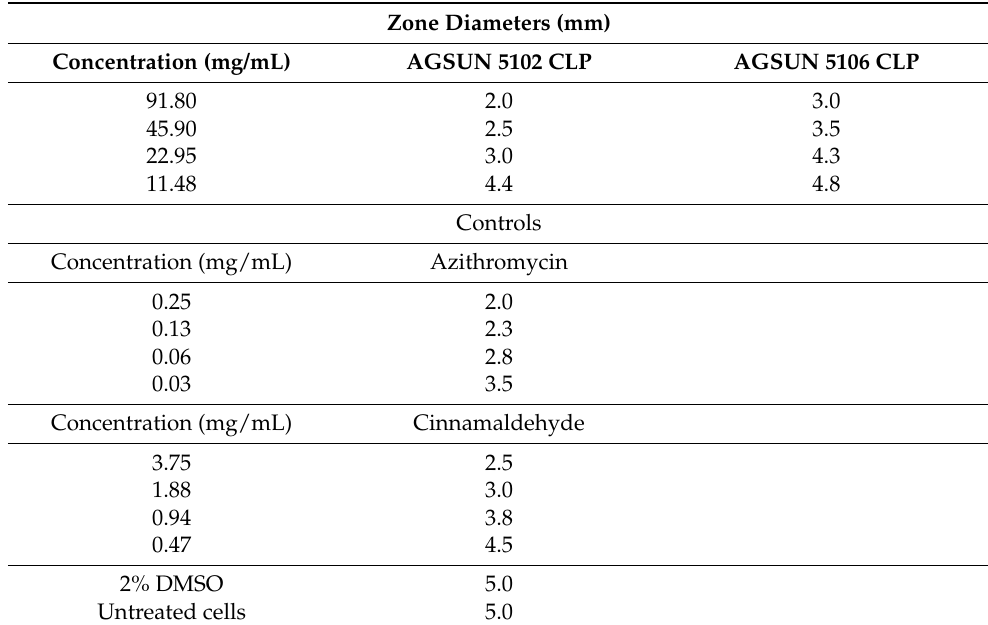
Table 3. Inhibitory effect of essential oils on QS-mediated virulence factor swarming motility of P. aeruginosa ATCC 27853 at sub-MIC concentrations (mg/mL).